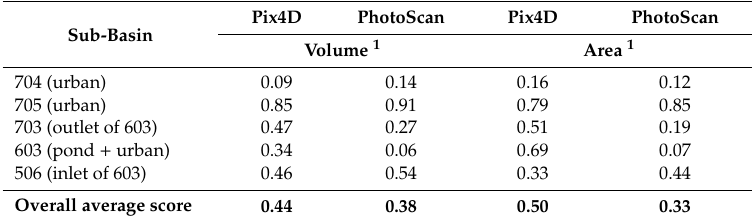
Table 6. Bray-Curtis similarity index of DEM flood estimations with respect to LiDAR reference.